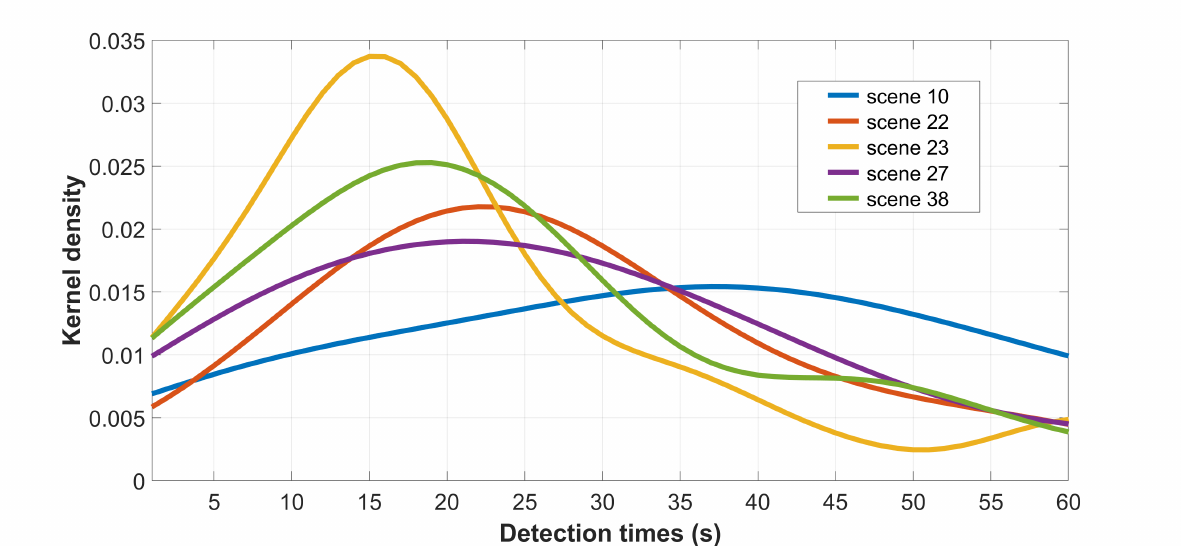
Figure 4. Example of non-normal distributions of detection times. Note: these are kernel density estimates (Gaussian kernel–Silverman rule for bandwidth tuning) from the raw detection times, which are originally in the 1 to 60 s